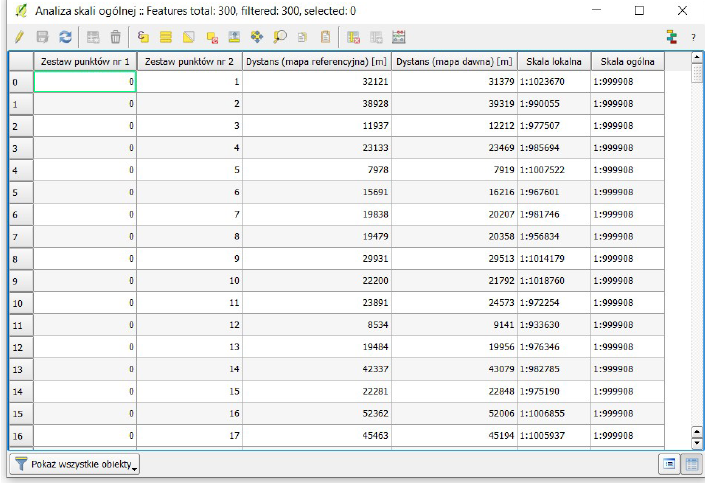
Fig. 4. An example of the result layer attribute table of the algorithm calculating the general scale of the old map (prepared by M.